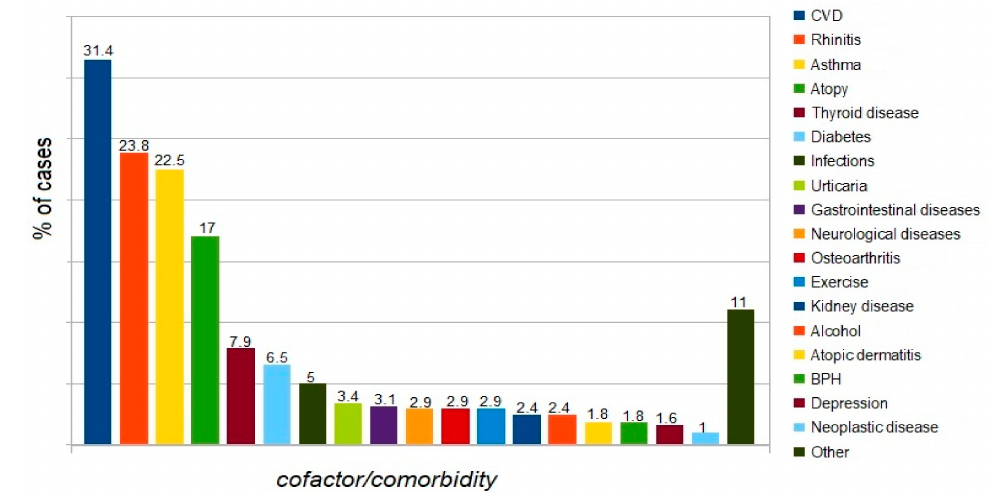
Figure 3. Proportion of patients with a specific cofactor/comorbidity in the analyzed group. Presence of comorbidity/cofactor: one factor vs. two vs. three vs. four vs. zero is shown in Figure 4. The comparison focused on the presence of one vs. two vs. three vs. four vs. zero comorbidity/cofactor revealed a significant difference between patients with one and those with three comorbidities/cofactors ( p < 0.01). Anaphylaxis was significantly more frequent in patients with one cofactor. No differences were found between patients with four comorbidities vs. other variants because of the low number of patients with four